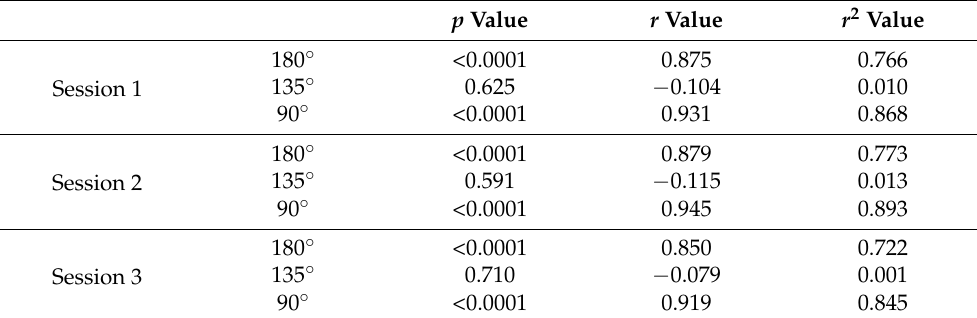
Table 5. Correlation between ASH test results using Active5™ and K-Force plates in the dominant upper limb in the female group.